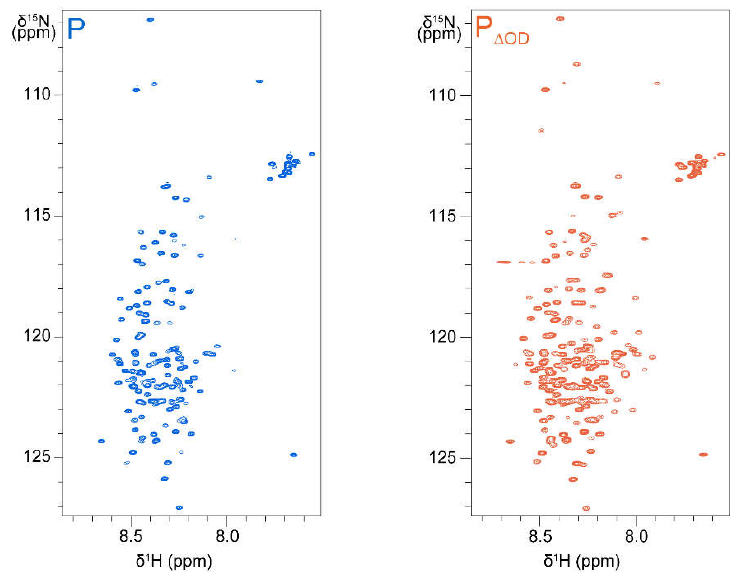
Figure 3. 2D 1 H– 15 N HSQC spectra of full-length RSV P and P ΔOD , a deletion mutant of P devoid of the oligomerization domain. Acquisition was done at a temperature of 288 K and at a magnetic field of 14.T (600 MHz 1 H resonance frequency), using a triple resonance cryoprobe equipped with Z-axis gradients. Samples contained 175 µL of protein at concentrations of 250 µM for P and 80 µM for P ΔOD , in a 20 mM Na phosphate 100 mM NaCl buffer at pH 6.5, and 15 µL of D 2 O to lock the NMR spectrometer frequency. Assignments are not indicated, but can be retrieved from